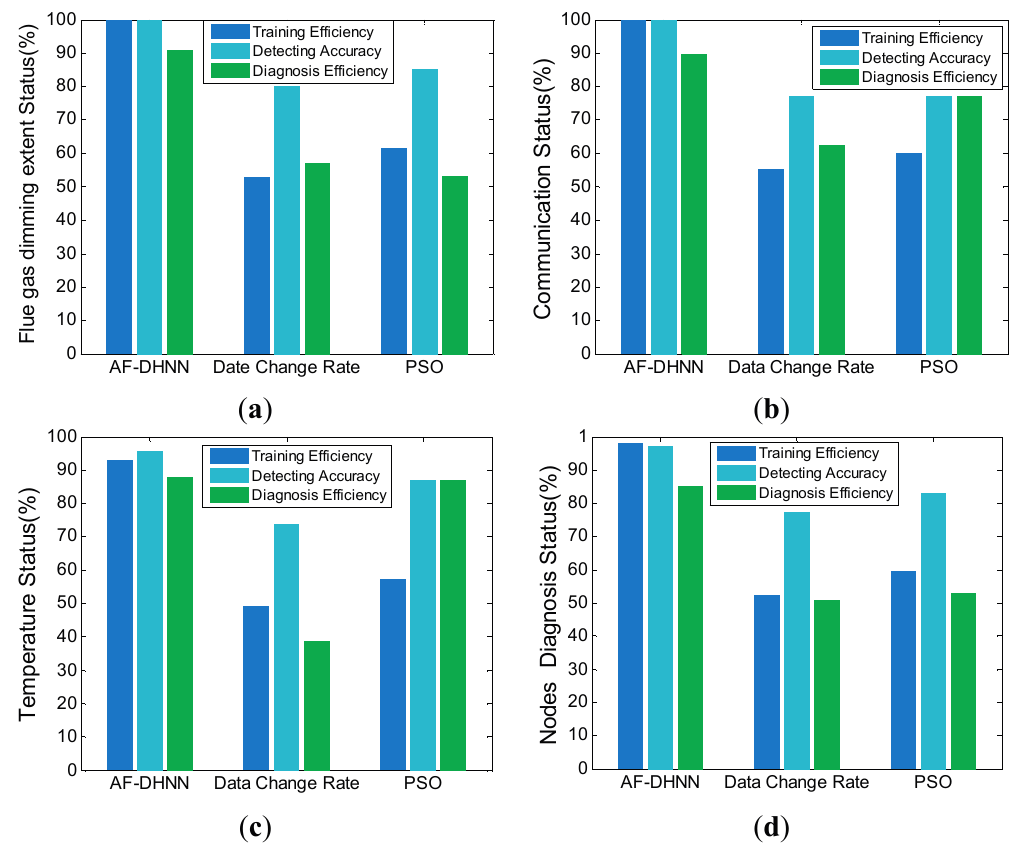
Figure 16. The diagnosis performance comparison in normal environment. ( a ) flue gas dimming extent status; ( b ) communication status; ( c ) temperature status; ( d ) nodes diagnosis